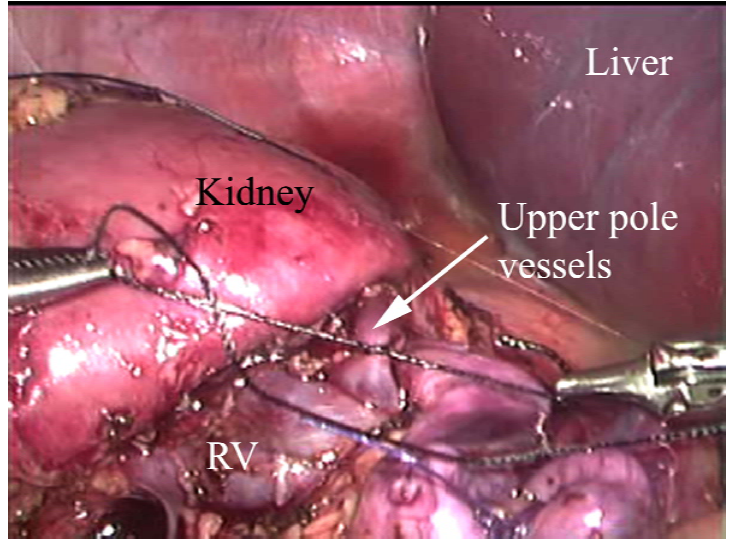
FIGURE 1 . Suture ligation of upper pole renal vessels during partial nephrectomy. The dexterity of the robotic instruments permits efficient use of suture ligation, which can be more accurate than clip placement in